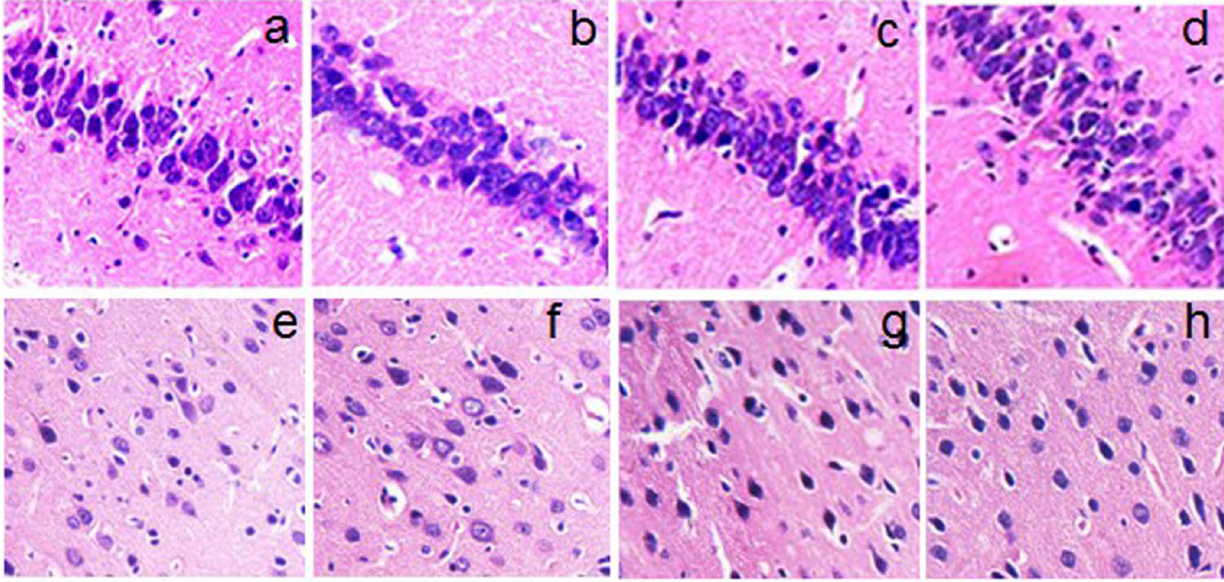
Figure 3. Effect of pioglitazone on histopathological changes in the hippocampus (a–d) and temporal cortex (e–h) of fructose- drinking insulin resistance rats. The hippocampal CA1 area (a,b) and temporal cortex (e,f) in the control, and the pioglitazone-treated control groups, rare damaged cells were seen. In the hippocampal CA1 area (c,d) and the temporal cortex (g,h) of the fructose-drinking insulin resistance control and the pioglitazone-treated groups, neurondegeneration was evident, but not difference was found between the two groups. The data were from five independent experiments. Magnification: 6 200.